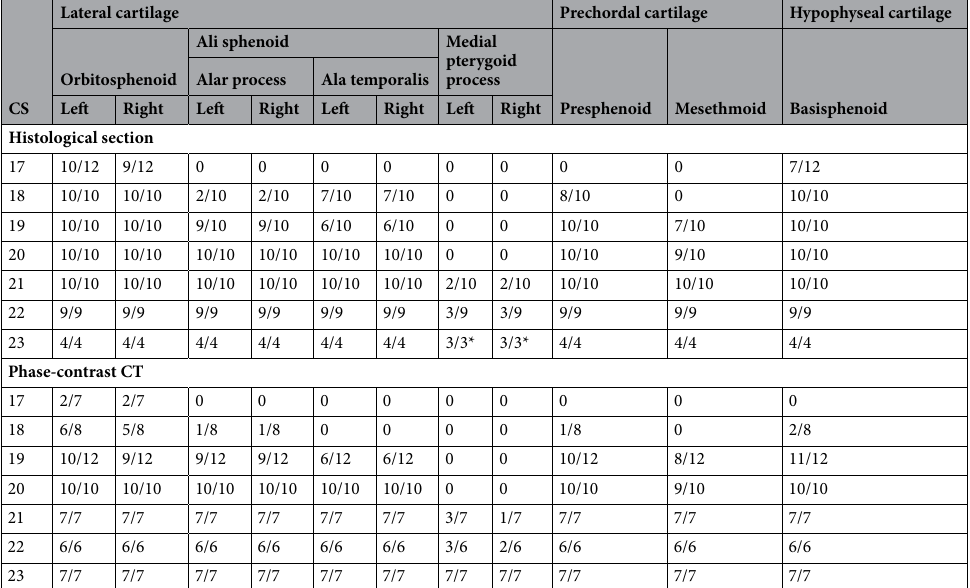
Table 2. Appearance rate of the sphenoid elements. *In one specimen of CS 23 (#2530), several slices around the medial pterygoid process were missing.